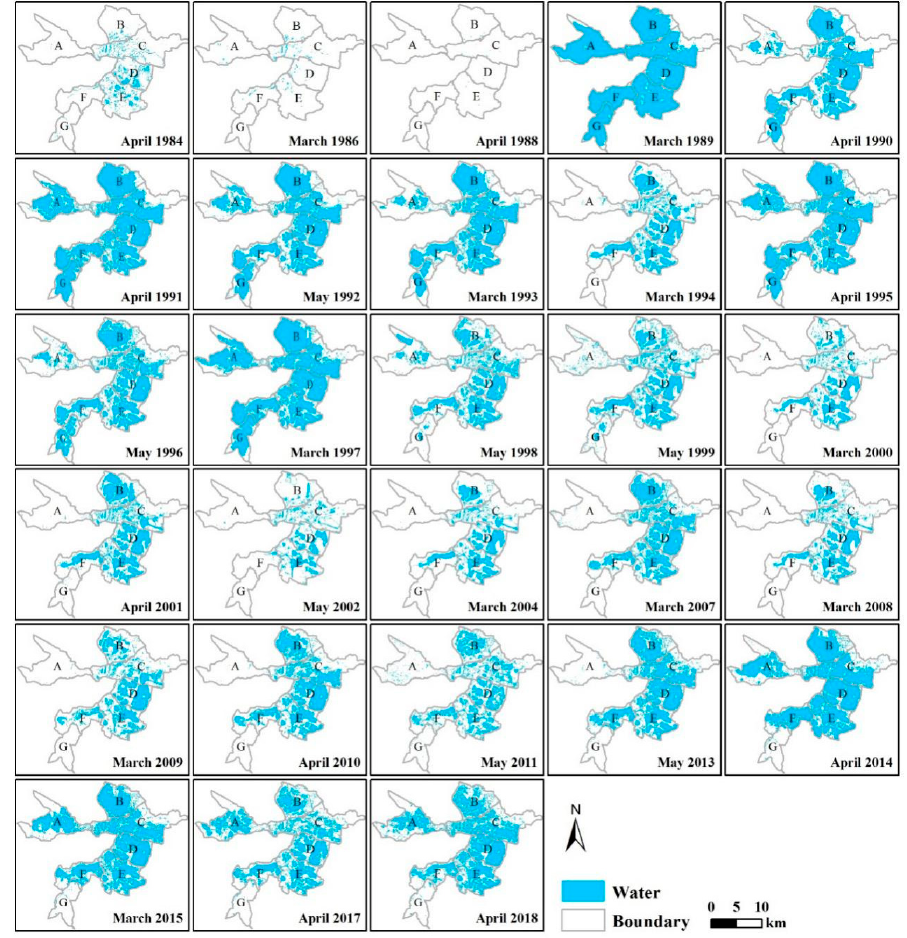
Figure 12. Spatial variations in water area from 1984 to 2018 in Baiyangdian Lake.